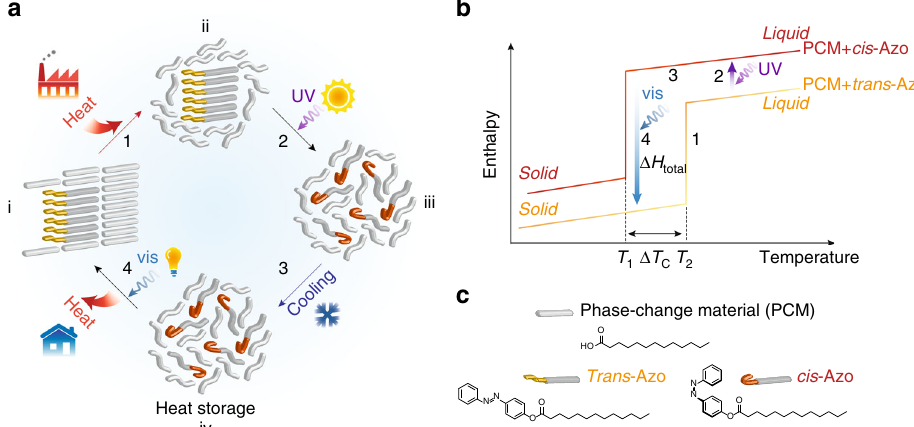
Fig. 1 Optically controlled thermal energy storage and release cycle. a Schematic of (1) thermal energy absorption by phase-change materials (PCM) composite, (2) ultraviolet (UV) illumination for photoisomerization of azobenzene dopants, (3) cooling of lique fi ed PCM composite, and (4) visible-light (vis)-triggered reverse isomerization and heat release. The straight and curved rods exhibit different degrees of translational and rotational freedom, i.e., different phases. b Schematic energy diagram of PCM composites containing uncharged ( trans -Azo) or charged ( cis -Azo) dopants, showing enthalpy and temperature changes along (1) – (4) stepwise process for the thermal energy storage and release cycle. T 1 and T 2 are crystallization points of charged and uncharged composites, respectively, and Δ T c is the difference between T 1 and T 2 . Δ H total represents the expected heat release from the optically discharged composite. c Chemical structures of PCM (tridecanoic acid) and the azobenzene dopant, functionalized with tridecanoic ester group, in